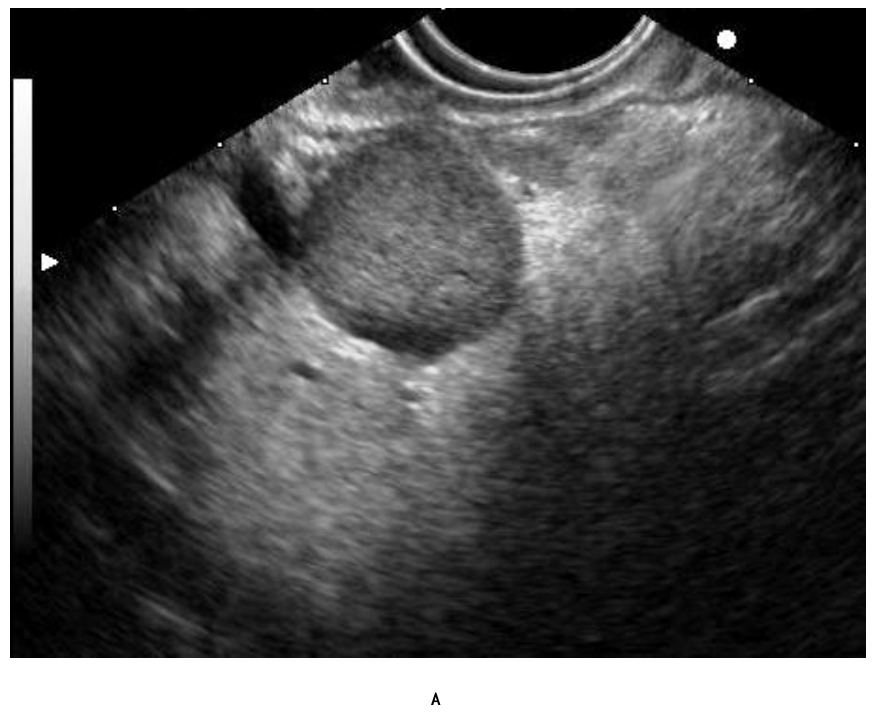
FIGURE 6 . (A) Endocrine tumor of the head of pancreas; (B) enhancement of vascularization after sonovue